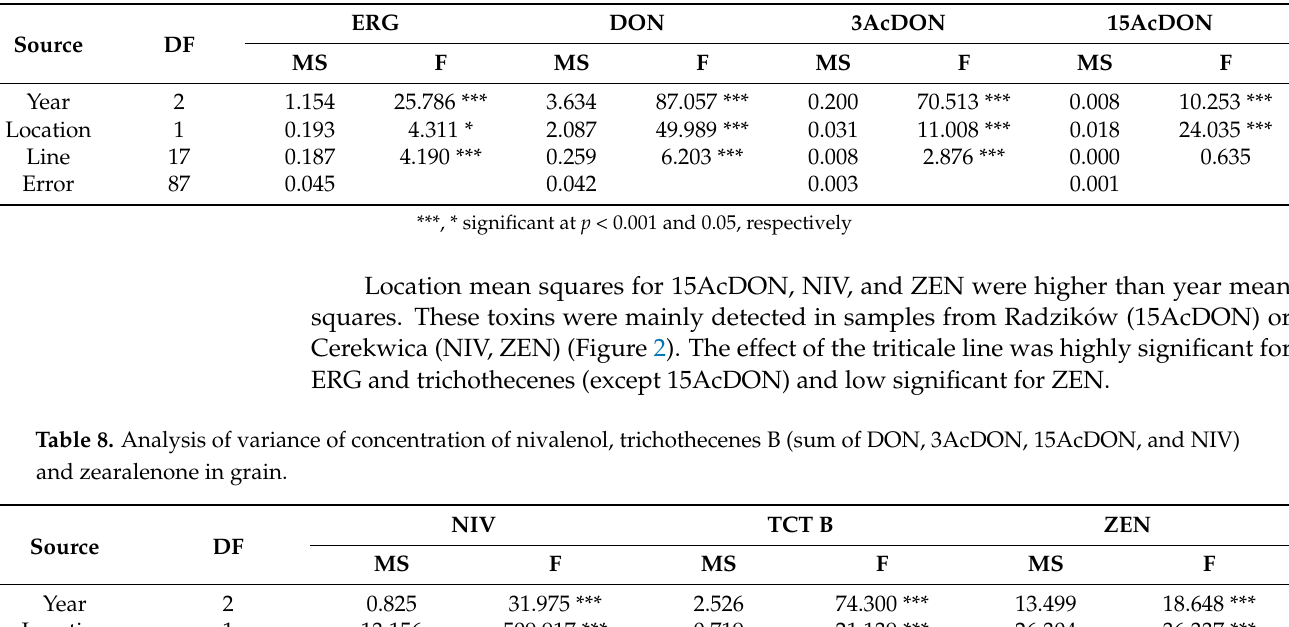
Table 7. Analysis of variance of concentration of ergosterol, DON, 3ACDON, and 15AcDON in grain.